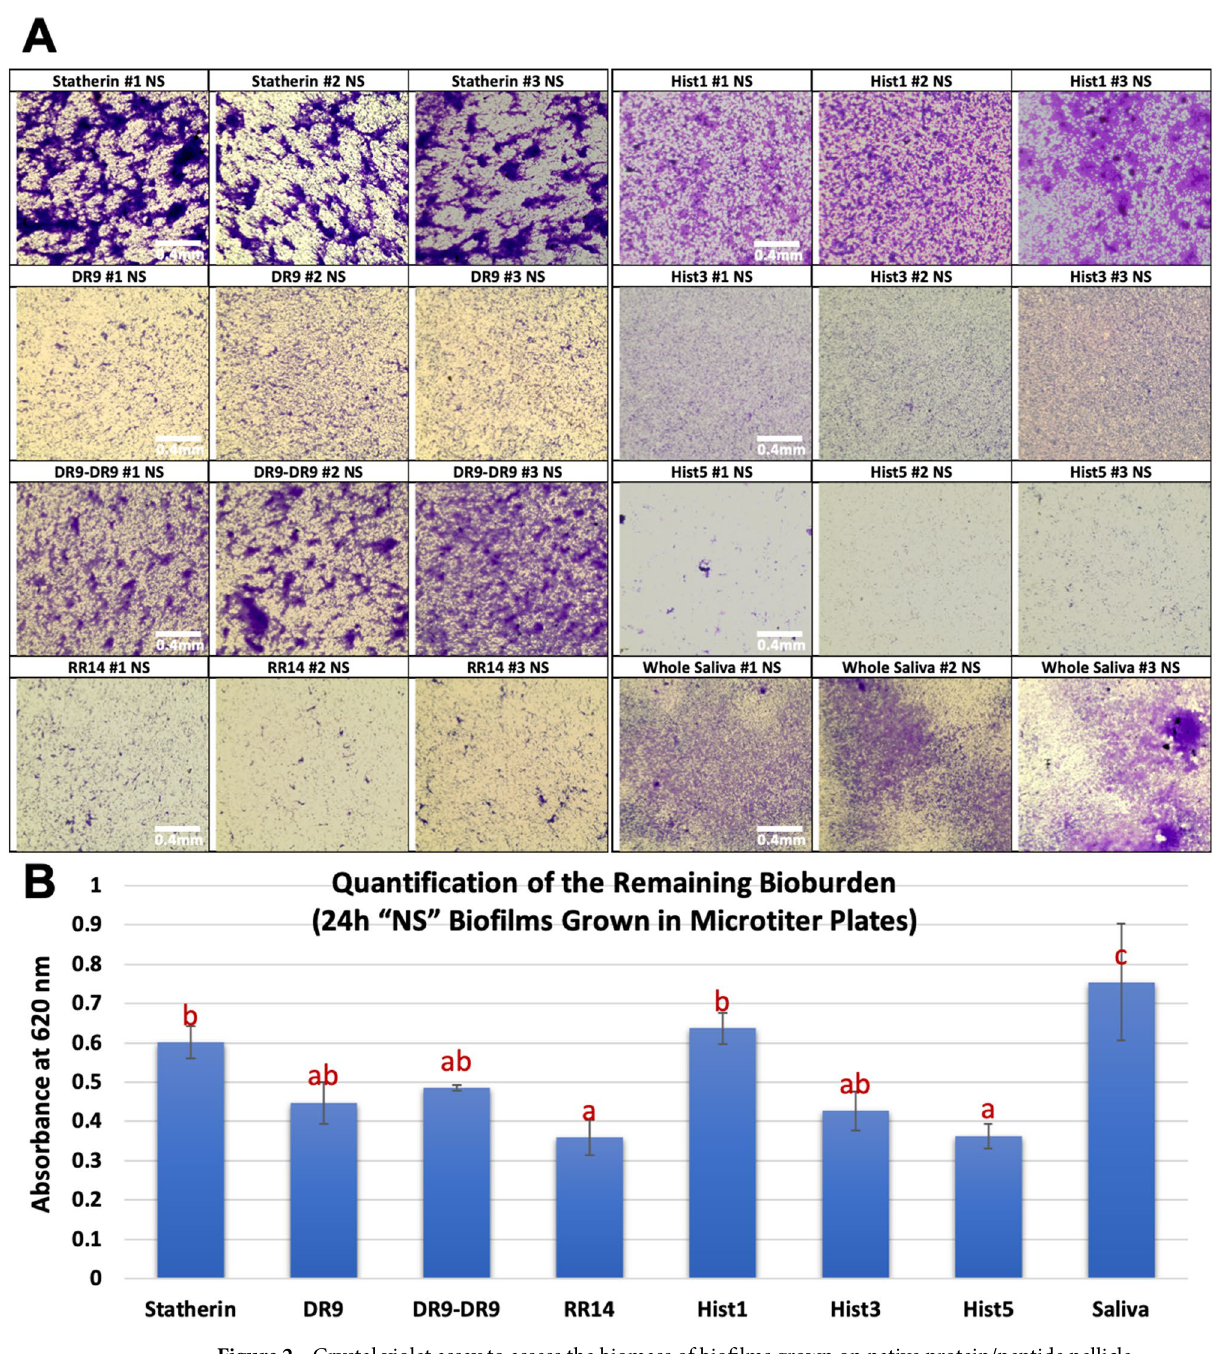
Figure 2. Crystal violet assay to assess the biomass of biofilms grown on native protein/peptide pellicle coatings: ( A ) Inverted brightfield microscope characterization of the crystal violet-stained 24 h S. mutans U159 biofilms. All biofilms were grown in polystyrene microtiter well plates pellicle-coated with native, except (DR9-DR9), protein/peptide candidates listed in Table 1. Filtered pooled whole saliva was used as a control. “NS” stands for “No Sucrose” where the biofilms were grown in BHI medium without sucrose supplementation. Scale bar is 0.4 mm. ( B ) Quantification of the remaining bioburden after dissolving in 33% acetic acid. Distinct lower-case letters show significant differences among groups (ANOVA and Tukey’s (HSD) post-hoc tests, p < 0.05; Mean ± SD). Hist1, Histatin1; Hist3, Histatin3; Hist5,